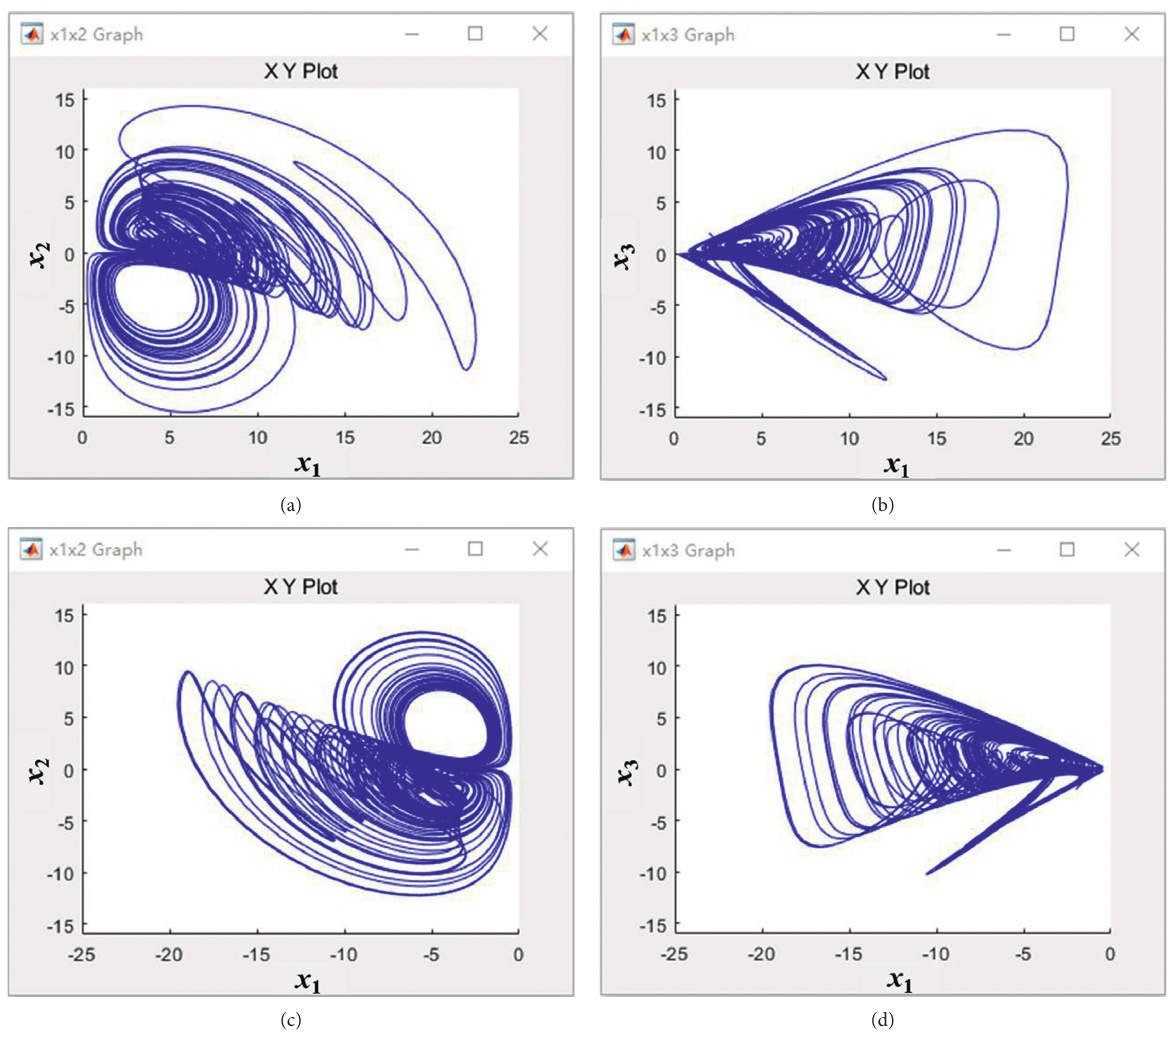
Figure 3: Formations of the phase diagrams that are plotted by “ XY Graph” in the MATLAB Simulink module block diagram. (a) x diagram and (b) x 1 x 3 phase diagram with IC � (2, 2, 2); (c) x 1 x 2 phase diagram and (d) x 1 x 3 phase diagram with IC � ( − 2, − 2, −